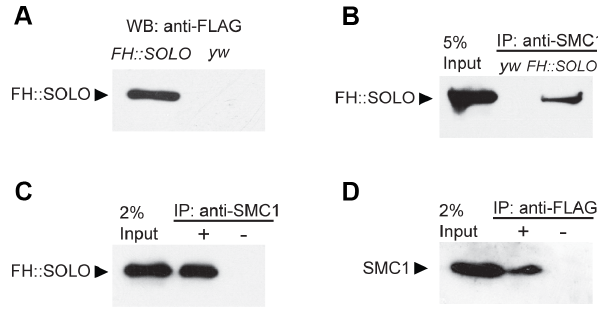
of protein extracts from FH::SOLO and y w ovaries using anti-FLAG antibody. Absence of signal in the y w lane shows that the anti-FLAG antibody is specific. (B) Immunoprecipitation with anti-SMC1 antibody from protein extracts from FH::SOLO and y w ovaries, analyzed with anti-FLAG antibody. (C) Immunoprecipitation with anti-SMC1 antibody or rabbit serum (mimic control) from FH::SOLO ovary extracts, analyzed with anti-FLAG antibody. (D) Immunoprecipitation with anti-FLAG antibody or mouse serum (mimic control) from FH::SOLO ovary extracts, analyzed with anti-SMC1 antibody.